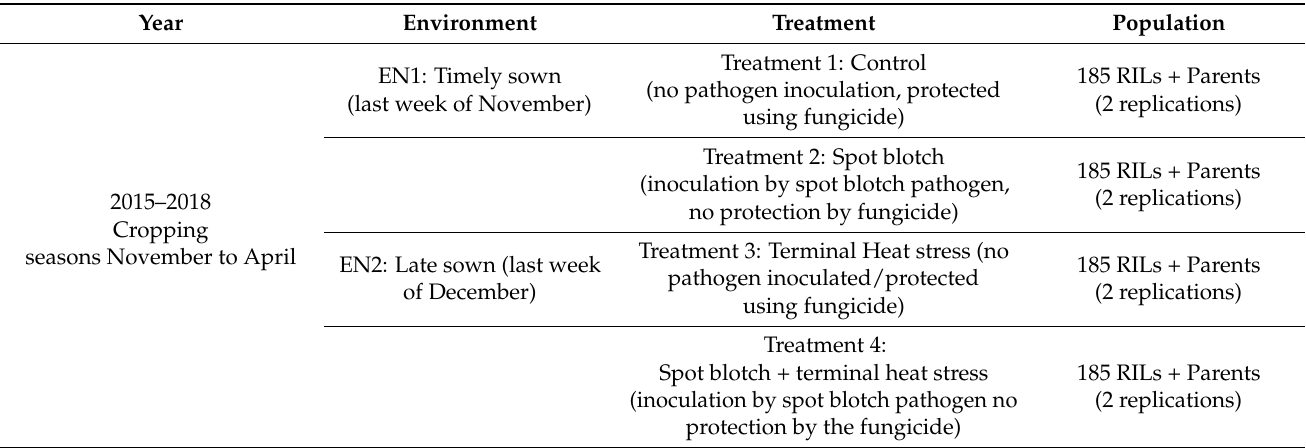
Table 4. Experimental layout for three consecutive cropping seasons (2015 to